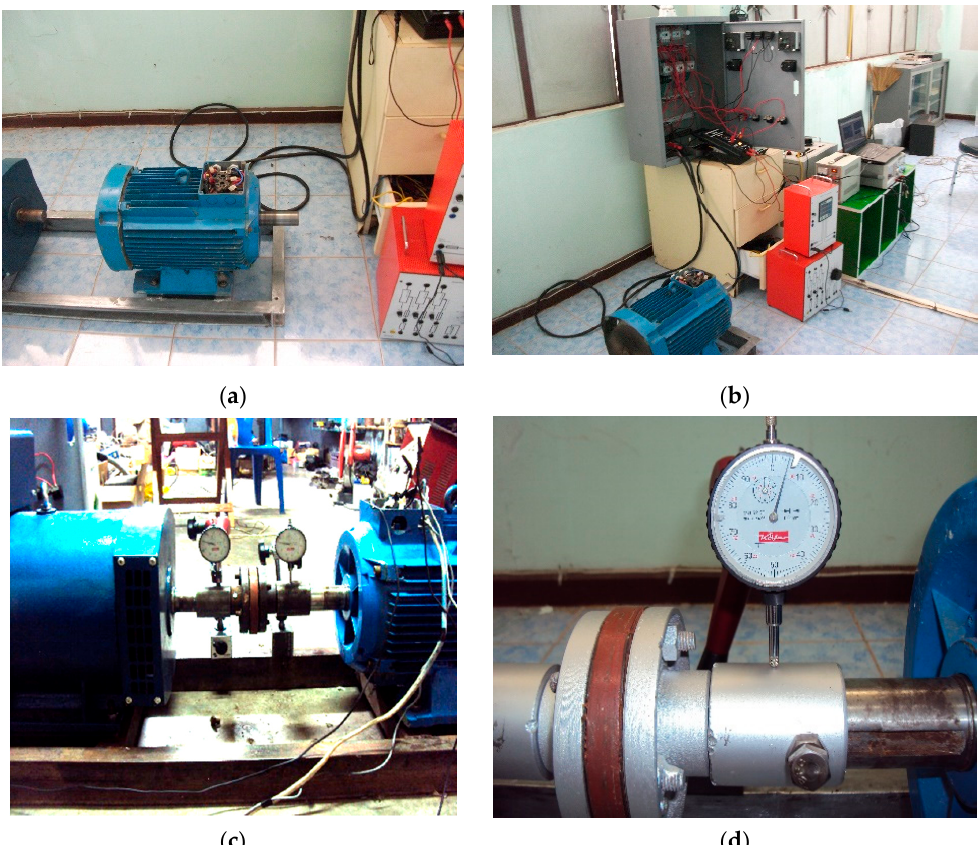
Figure 5. ( a ) Induction motor rated 11 kW, ( b ) testing motor with current sensing unit and low-pass filter circuit running without a load connected, ( c ) motor test connected to load, and ( d ) measuring the eccentricity of the rotor shaft with a dial gauge.